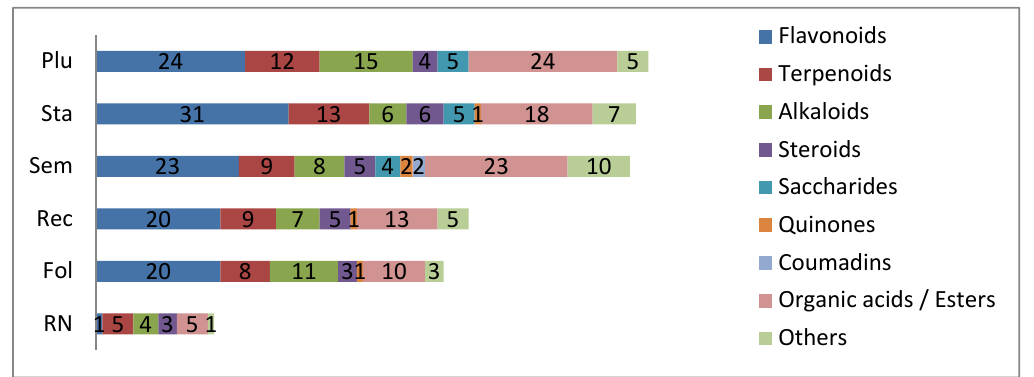
Figure 8. Type and number of compounds in the six parts of lotus.